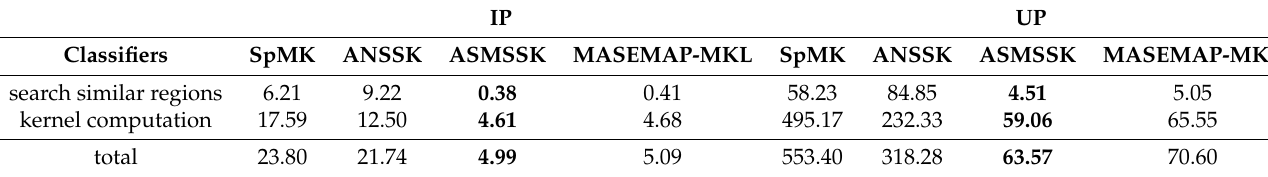
Table 4. Execution time (seconds) of different classifiers on the IP and UP datasets (the optimal results are shown in bold). IP